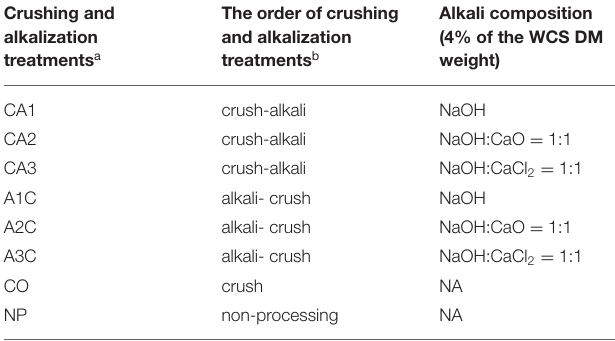
TABLE 1 | Crushing and alkalization treatments used to process